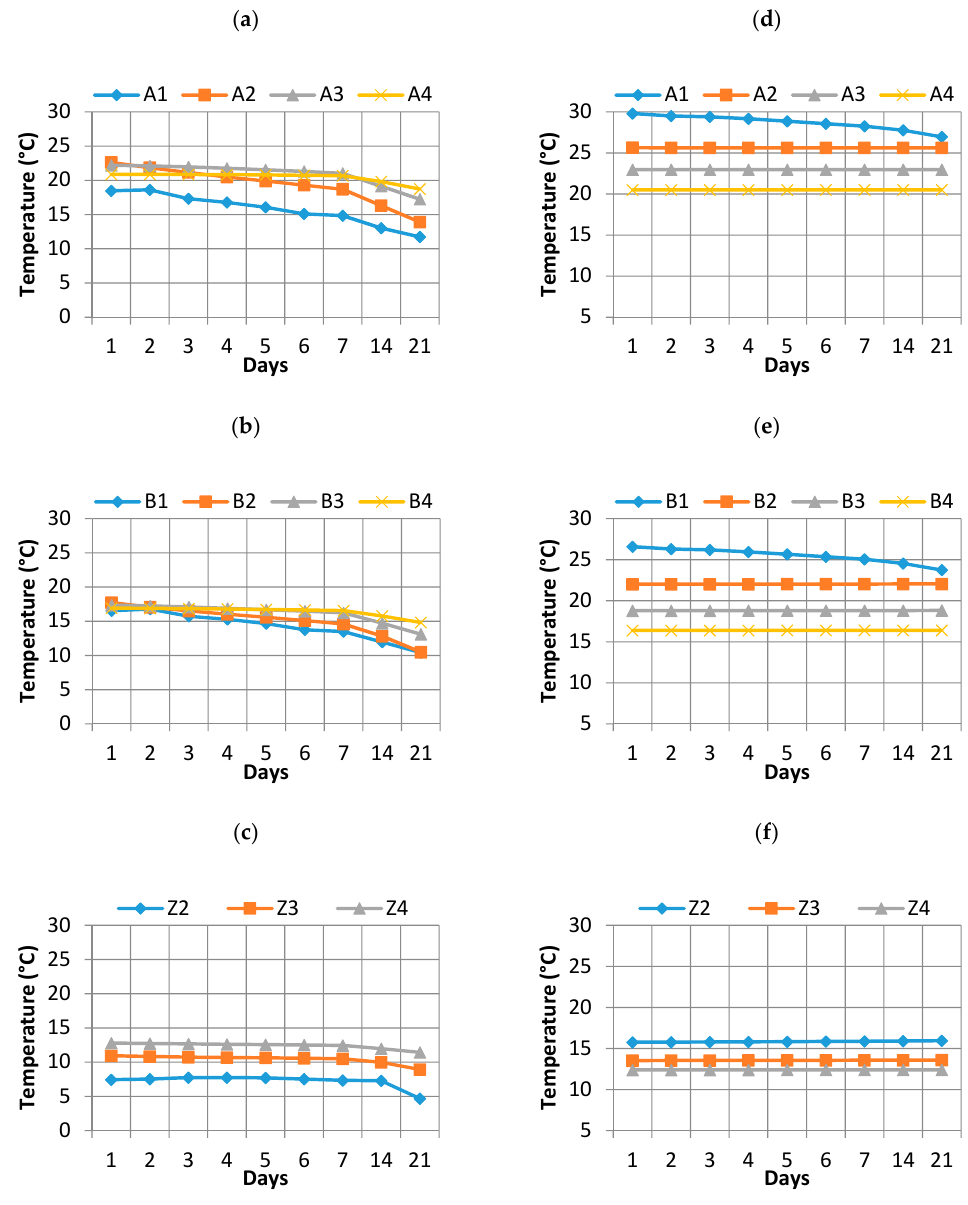
Figure 6. Floor and soil temperatures for technological interruption lasting 1, 2, 3, 4, 5, 6, 7, 14, and 21 days: ( a ) A1–A4, winter period; ( b ) B1–B4, winter period; ( c ) Z2–Z4, winter period; ( d ) A1–A4, summer period; ( e ) B1–B4, summer period; and ( f ) Z2–Z4, summer period.